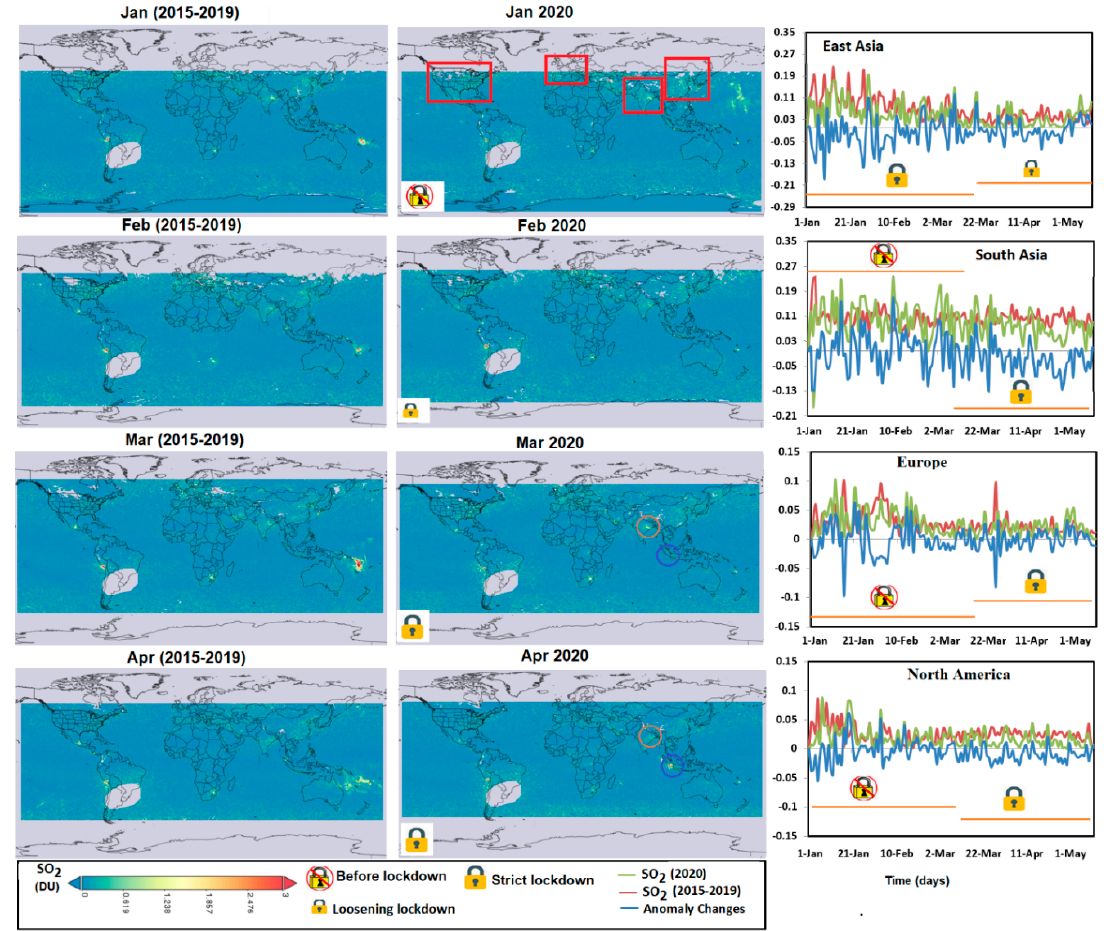
Figure 4. Spatial and temporal variations of SO 2 before and after the lockdown in 2020 compared with the baseline condition (2015–2019 averaged data).